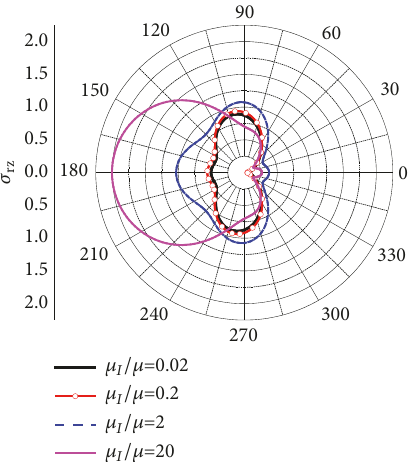
that the distribution of the radial stress differs from that of the